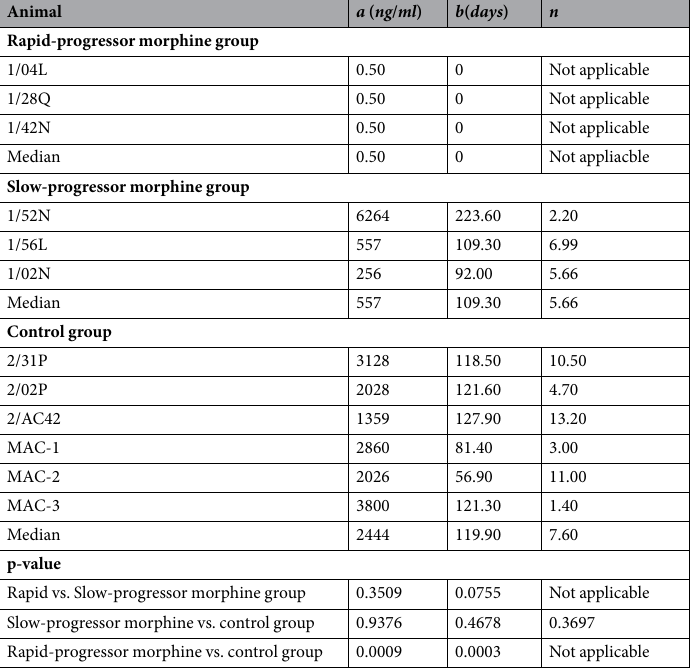
Table 1. Estimated values for a , b , and n for individual animals, and p-values used to test significance of the estimated values.